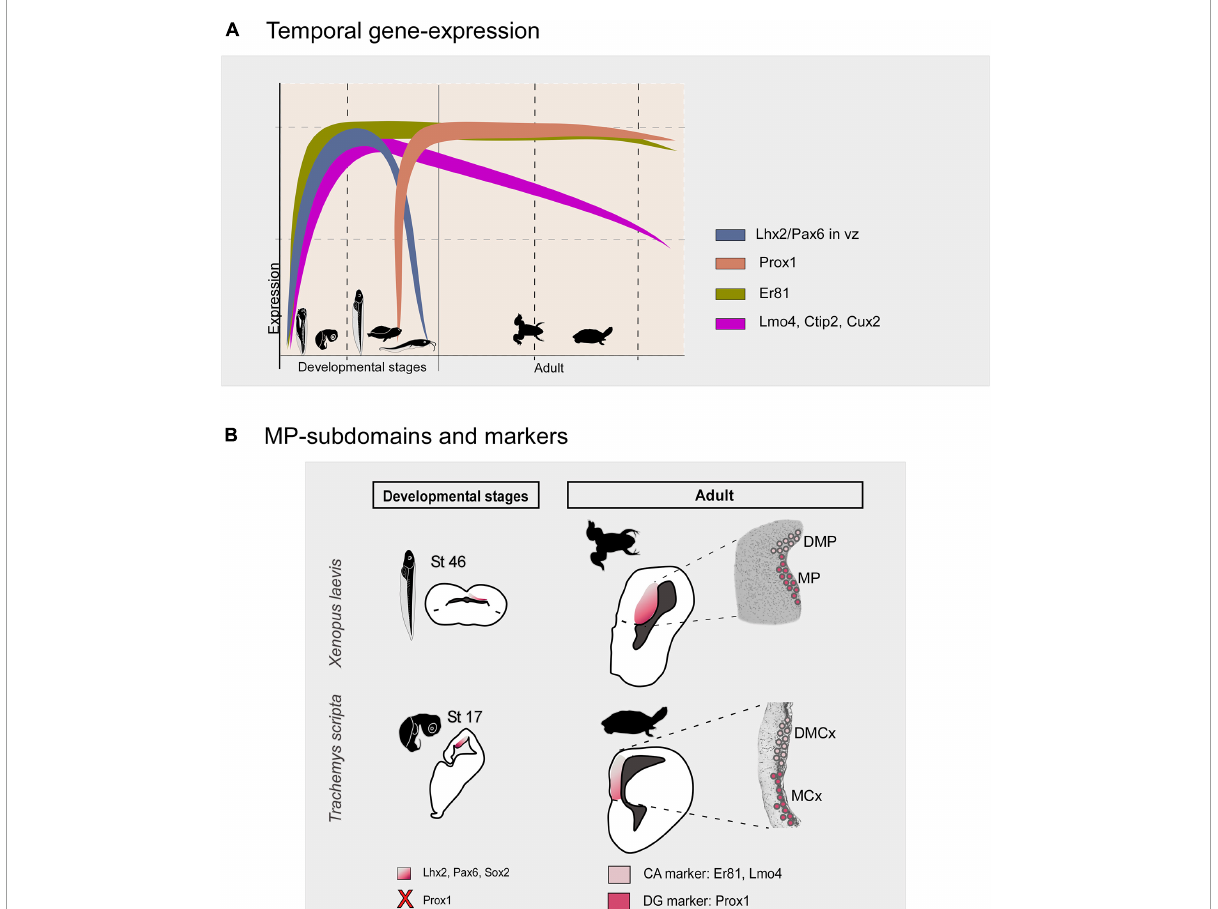
FIGURE13 (A) Summary diagram of the temporal gene expression of the markers analyzed in this study in the medial pallium of Xenopus laevis and Trachemys scripta elegans . (B) Schematic representations in development and adult showing that there are two subdivisions in both models, the MP/MCx: Prox1 + and the DMP/DMCx: Er81/Lmo4 +, related to mammalian DG and CA respectively. The X in the diagram indicates the lack of Prox1 expression at these developmental stages. The color code is indicated in each figure. Silhouette images of adult animals were obtained from phylopic.org . See the abbreviation